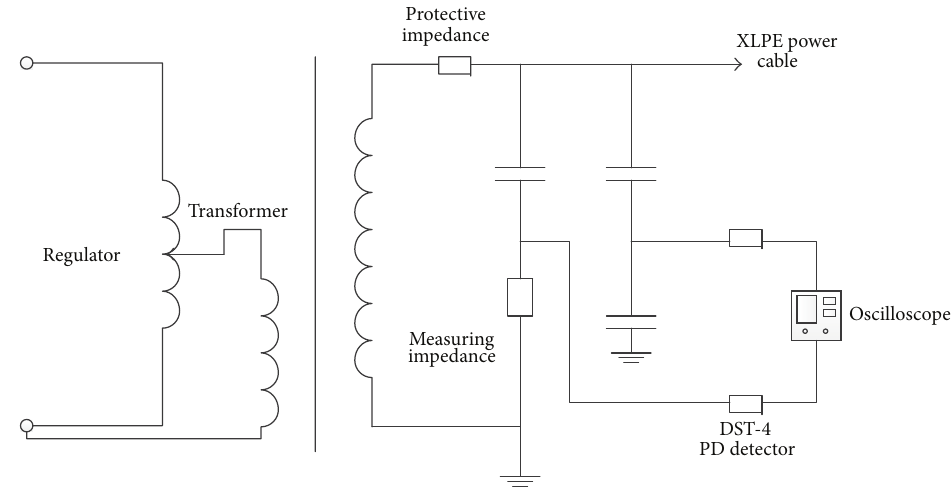
Figure 5: Real data of discharge signal recording system.